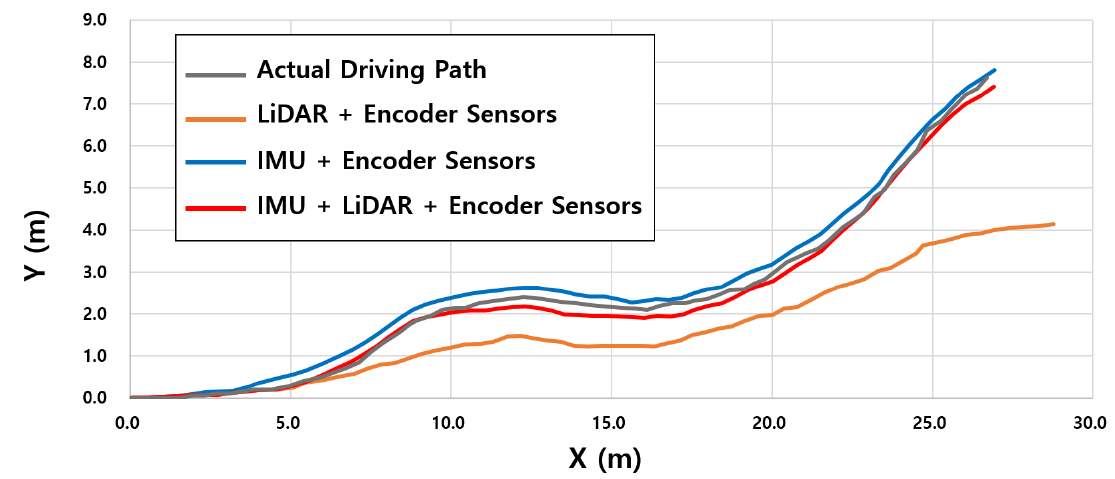
Figure 12. Autonomous robot’s driving path estimated by the three location estimation methods (IMU + encoder, LiDAR + encoder, and IMU + LiDAR + encoder sensors), and the actual driving path in the field experiment.